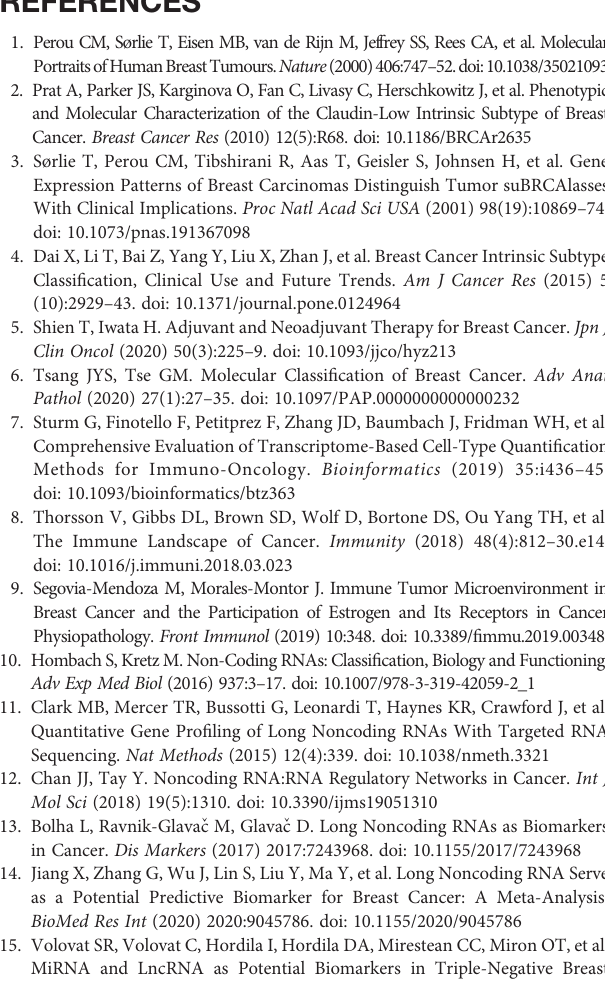
Supplementary Figure 4 | Kaplan-Meier analysis for overall survival for LINC01871 in Basal (A) and XXYLT1-AS2 in Her2 (E) and for Progression Free Interval for MEG3 in LumA (B) , EBLN3P in LumB (C) and LINC02613 in Normal (D) . The groups of High and Low expressions are based on the median value of its respective lncRNA expression. Con fi dence interval and logrank p-value are shown and values below 0.05 are considered signi fi cant. Supplementary Table 1 | Breast cancer cohort strati fi cation into the immune subtypes. Supplementary Table 2 | Ensembl and HGNC Symbol from lncRNAs used in this study. Supplementary Table 3 | First and second SNR calculated for lncRNAs for each molecular subtype. Supplementary Table 4 | Cox Proportional Hazard models for the speci fi c immune-related lncRNAs and Leukocyte correlation. Supplementary Tables 5 – 9 | GSEA Hallmarks analysis for the speci fi c immune- related lncRNAs organized by the molecular subtype. Supplementary Tables 10 | Data sets, software and algorithms used in this